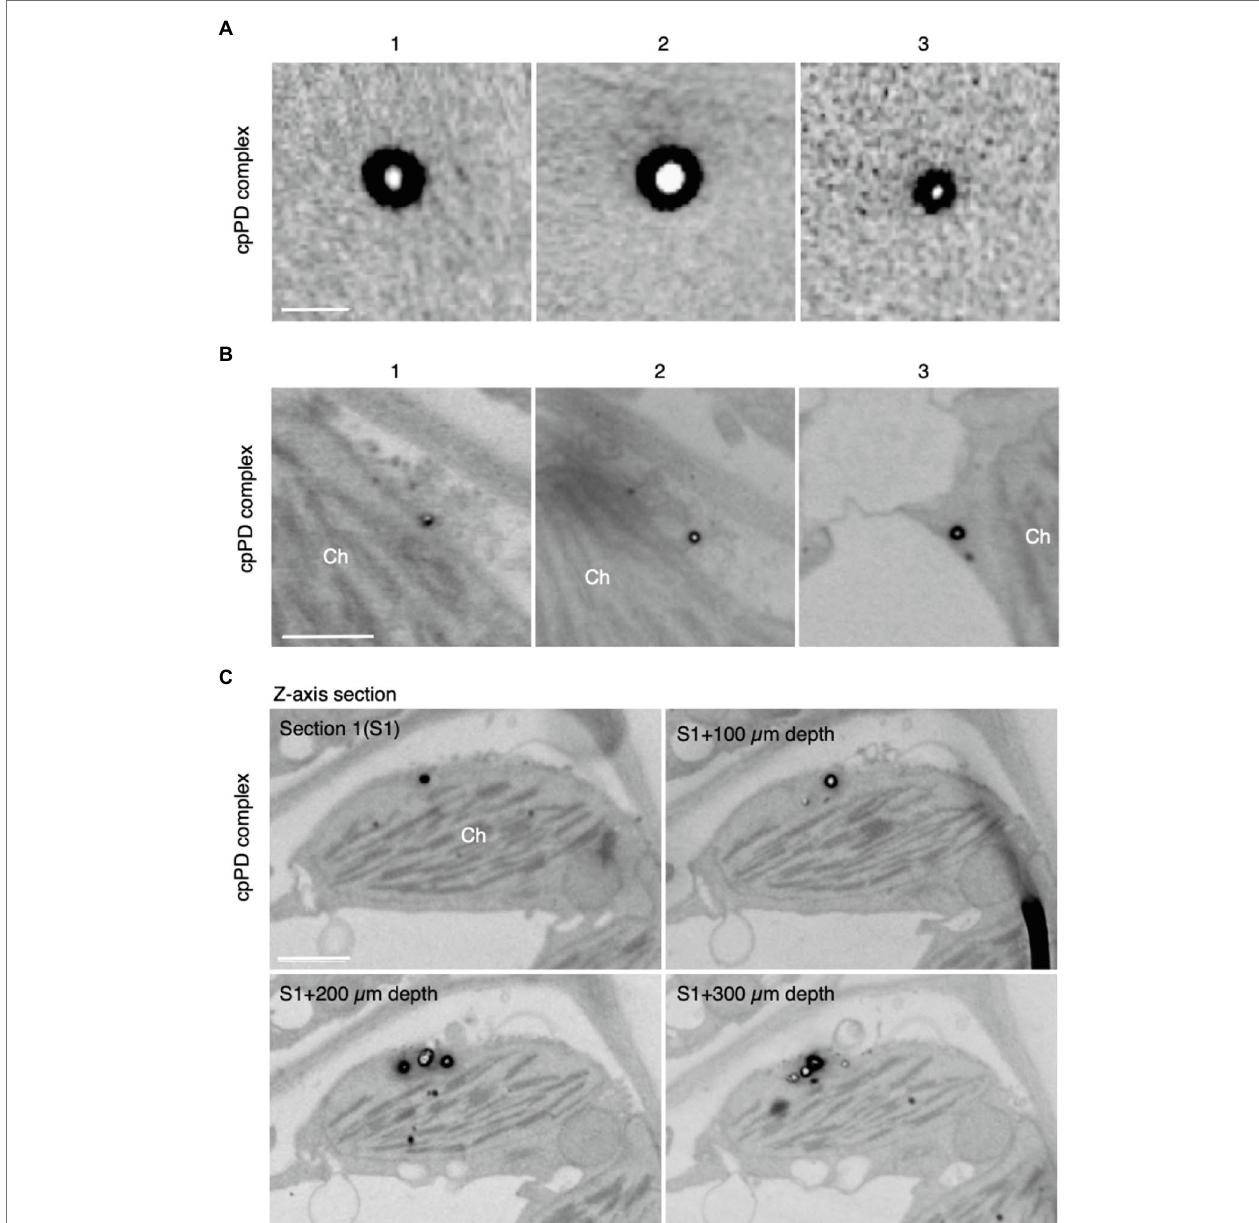
FIGURE 2 | Field emission-scanning electron microscopy (FE-SEM) analysis of KH-AtOEP34-pDNA complexes. (A,B) Three different images of the KH-AtOEP34– pDNA (cpPD complexes; 1–3 ) in agarose gel (A) and around chloroplasts (Ch; B ) are shown. (C) Four consecutive z -axis sections showing cpPD complexes on the chloroplast surface. The sections are cut at every 100 μ m depth. Bars = 100 nm in (A) and 1 μ m in (B,C)